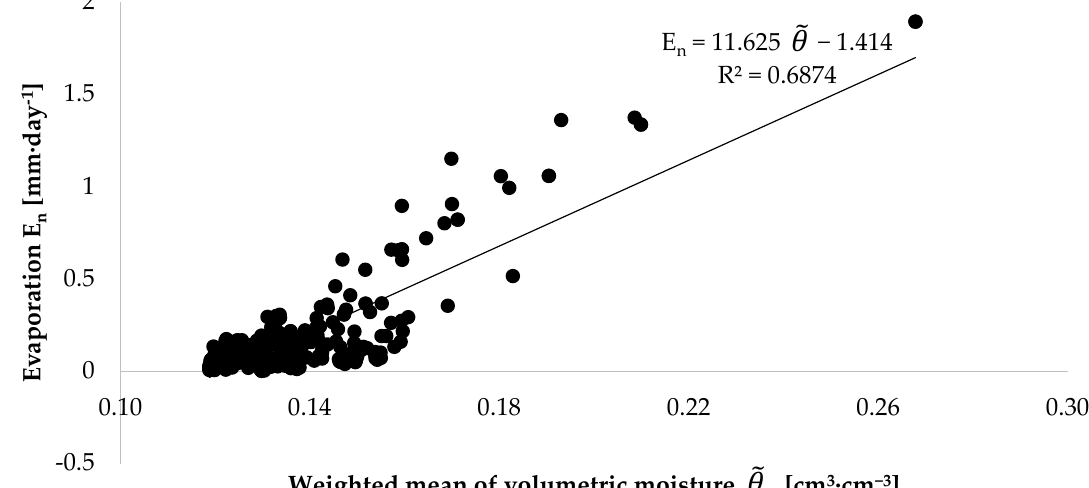
Figure 11. Relationship between daily evaporation and weighted mean of volumetric moisture for the 12 pots, calculated separately for each day on which the experiment was performed.